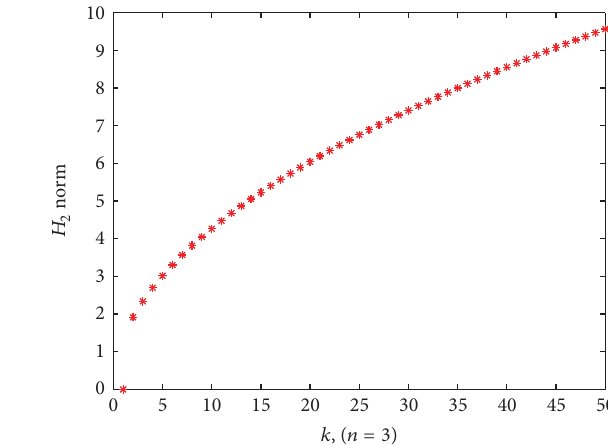
Figure 4: The variance of 𝜆 2 for 𝐾 3 ∘ 𝑃 𝑘 .